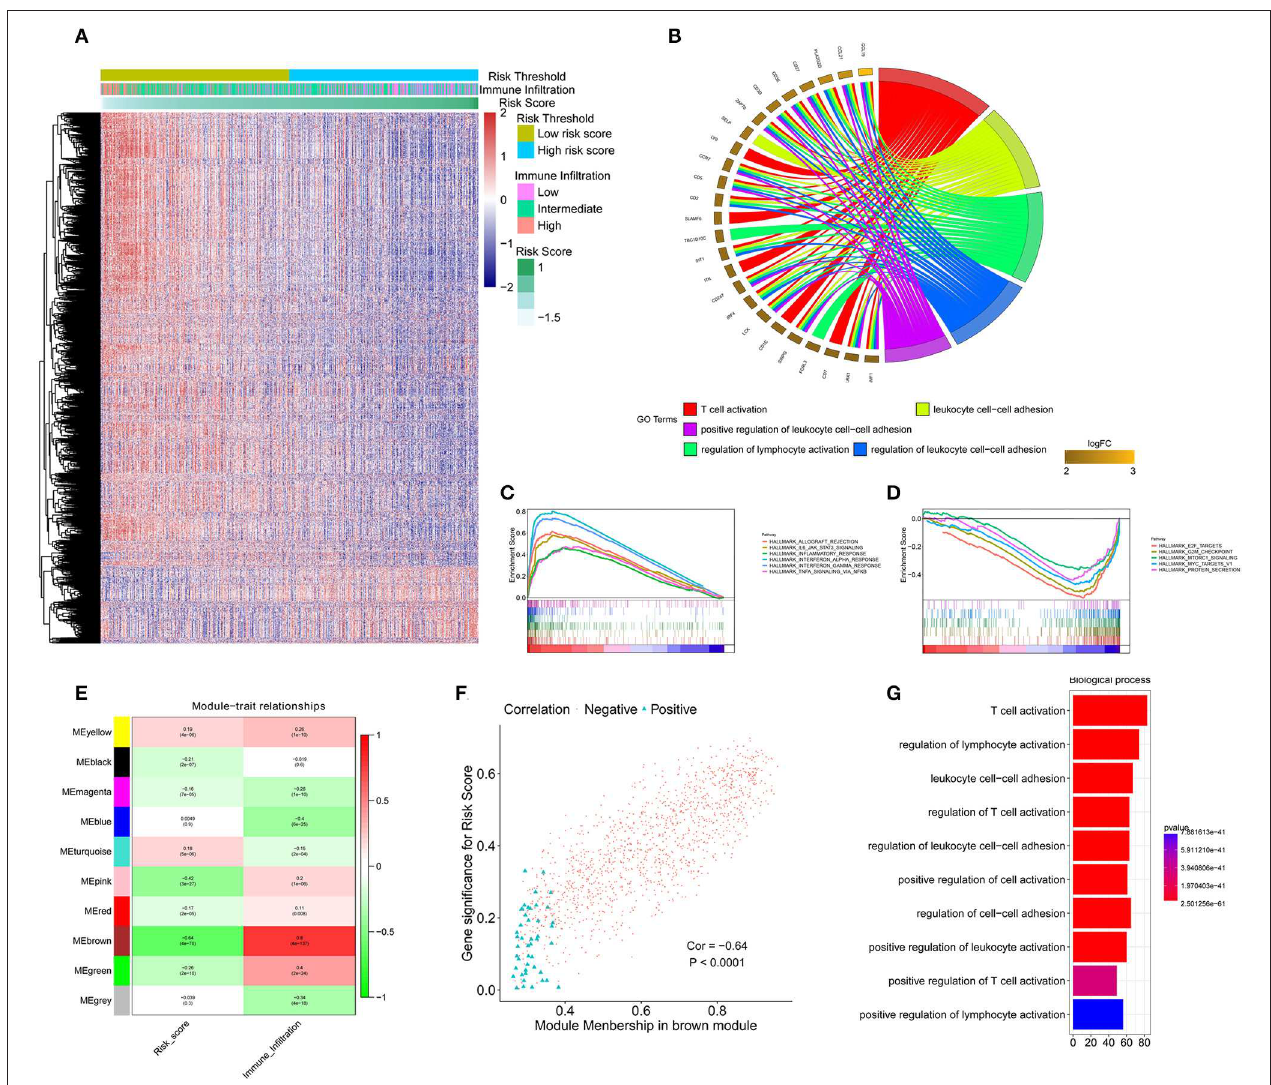
FIGURE 5 | Functional annotation of the immune signature and WGCNA of the IDC transcriptome. (A) Heatmap showing the transcriptome expression profiles of the low- and high-risk groups. (B) GO analysis based on the significant genes in the comparison between low- and high-risk groups. (C,D) GSEA revealed that most significant hallmarks correlated with the immune signature. (E) Correlation between modules and traits. (F) The correlation between module membership and gene significance in the brown module. (G) GO analysis based on the hub genes in the brown module. GO, gene ontology; GSEA, gene set enrichment